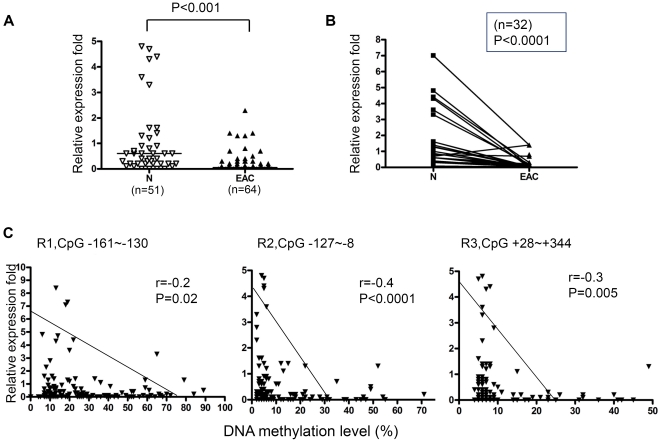
DNA methylation of the MT3 promoter correlates with MT3 gene expression.
A) Comparison of MT3 gene expression between esophageal adenocarcinoma (EAC) and normal samples (N includes normal squamous esophageal mucosa (NS) and normal glandular gastric mucosa (NG)). B) MT3 gene expression in 32 matched normal (N) and tumor (EAC) pairs. C) The differential correlation power of Region 1 (R1, from −161 to −130), Region 2 (R2, from −127 to −8) and Region 3 (R3, from +28 to +344) was demonstrated. Spearman correlation analysis was used to evaluate the significance between MT3 DNA methylation and mRNA expression. The Mann-Whitney test was used in A and B analyses.